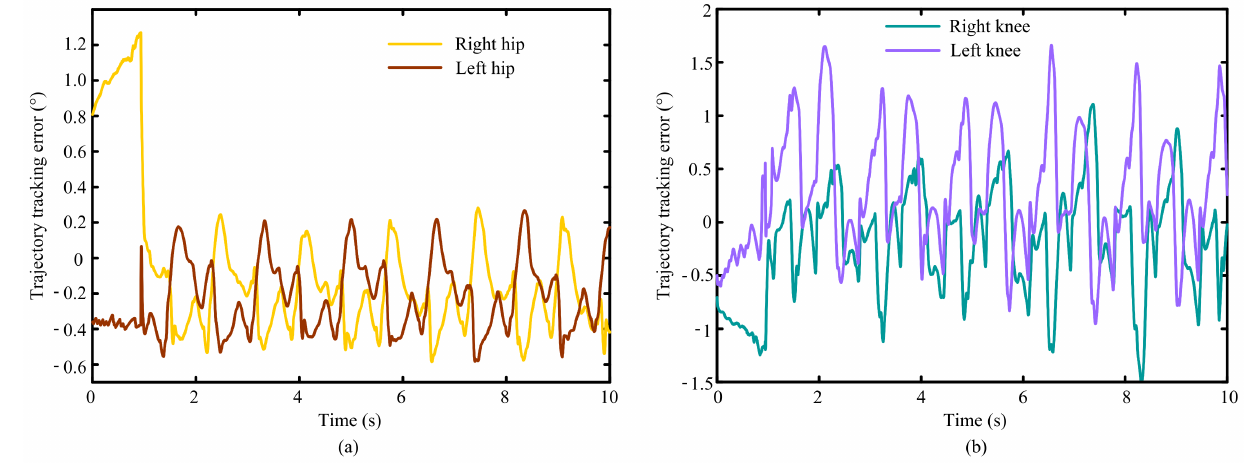
Figure 14. Trajectory tracking error curve of the ( a ) hip joint and ( b ) knee